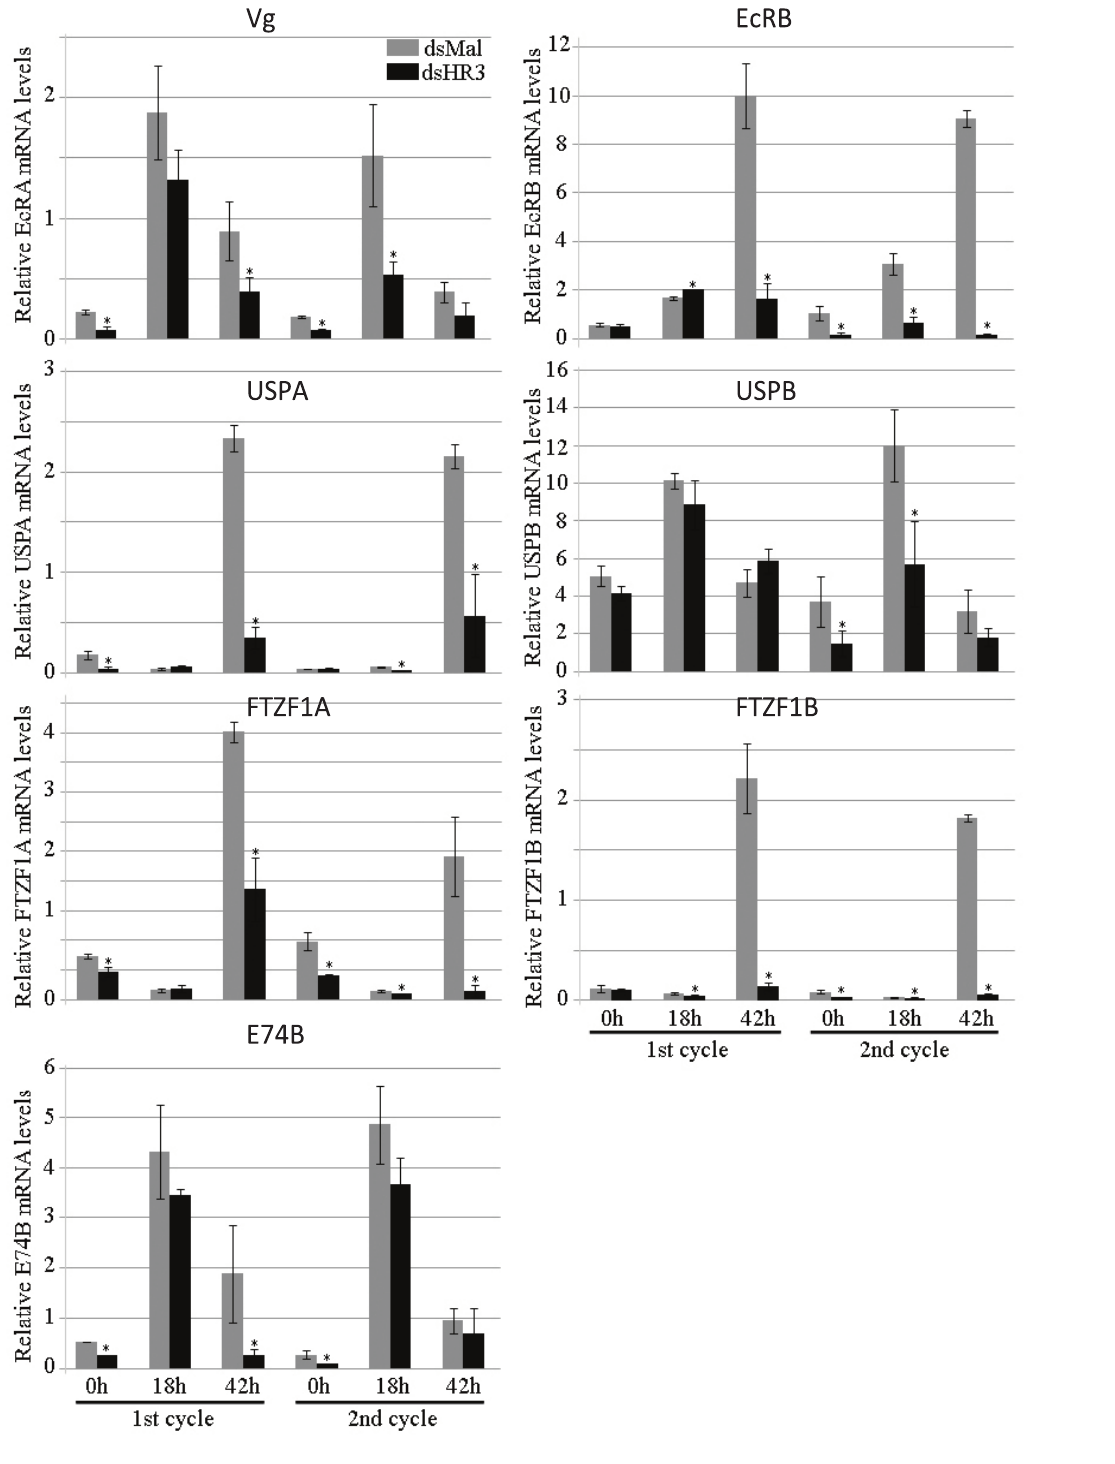
Figure 7. The effect of HR3 RNAi depletion on transcript levels of genes involved in the 20E response in the fat body of Aedes female mosquitoes during the first and the second gonadotrophic cycles. Transcript abundance of EcRA , EcRB , USPA , USPB , betaFTZ-F1A, and betaFTZ-F1B is represented. Five days after RNAi injection (dsMal as control or dsHR3), mosquitoes were given a blood meal. Mosquitoes were dissected at the indicated time points, as described in Materials and Methods. To study the second vitellogenic cycle, mosquitoes received a second blood meal 120 h after the first blood meal and egg laying. Each time point represents the average ( 6 SEM) of three groups of three FBs. Each sample was normalized to its internal control ribosomal protein-7 mRNA. Values represent an average of three groups of three FBs. Each experiment was repeated three times ( 6 SEM). *Indicates statistical significance , 0.05.